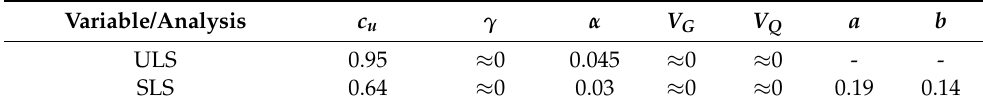
Table 12. First order Sobol indices for ULS and SLS